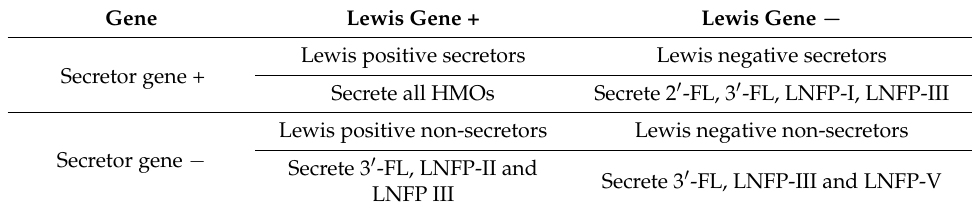
Table 1. Diversity of human milk oligosaccharides (HMO) based on genetic background of the mother. Gene Lewis Gene + Lewis Gene − Lewis positive secretors Lewis negative secretors Secretor gene + Secrete all HMOs Secrete 2 (cid:48) -FL, 3 (cid:48) -FL, LNFP-I, LNFP-III Lewis positive non-secretors Lewis negative non-secretors Secretor gene − Secrete 3 (cid:48) -FL, LNFP-II and LNFP III 2 (cid:48) -FL: 2 (cid:48) -fucosyllactose; 3 (cid:48) -FL: 3 (cid:48) -fucosyllactose; LNFP: